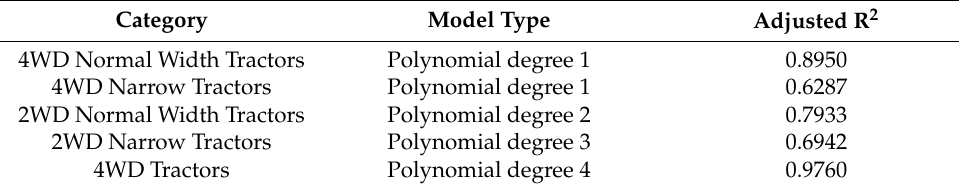
Figure 20. Price vs. power for 4WD new tractors. Table 8. Summary of results of segmentation by category for new tractors.